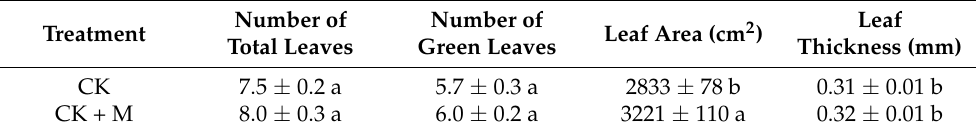
Table 1. Effects of wood vinegar on the growth of rapeseed seedlings under low-temperature stress.